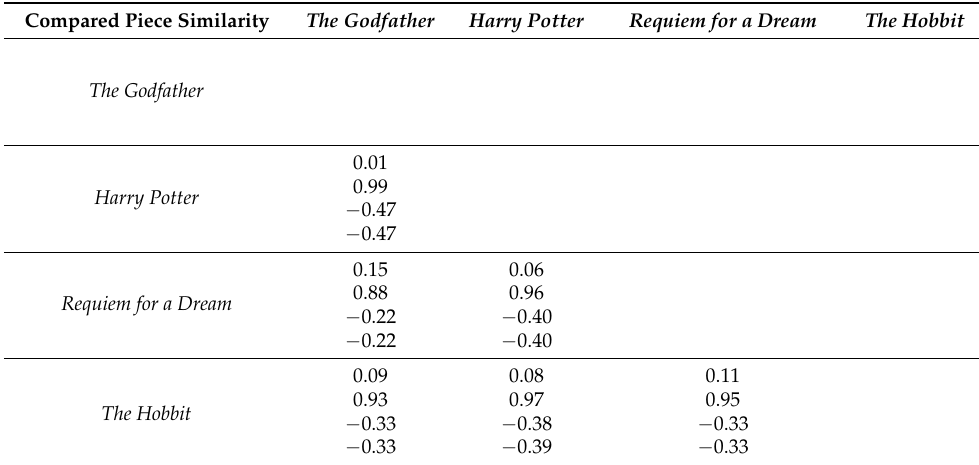
Table 3. Comparison of pieces from the film music